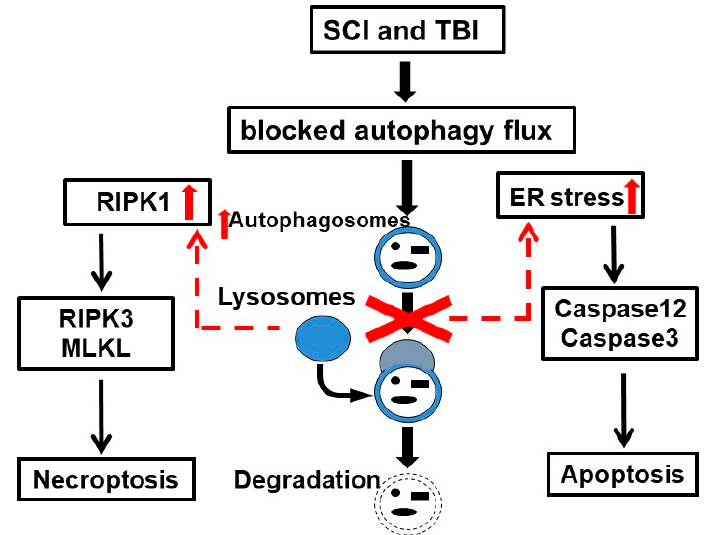
Figure 2. Lysosomal damage after spinal cord injury (SCI) and traumatic brain injury (TBI) cause endoplasmic reticulum (ER) stress and the accumulation of receptor interacting protein kinases (RIPK1 / RIPK3), leading to neuronal apoptosis and necroptosis.